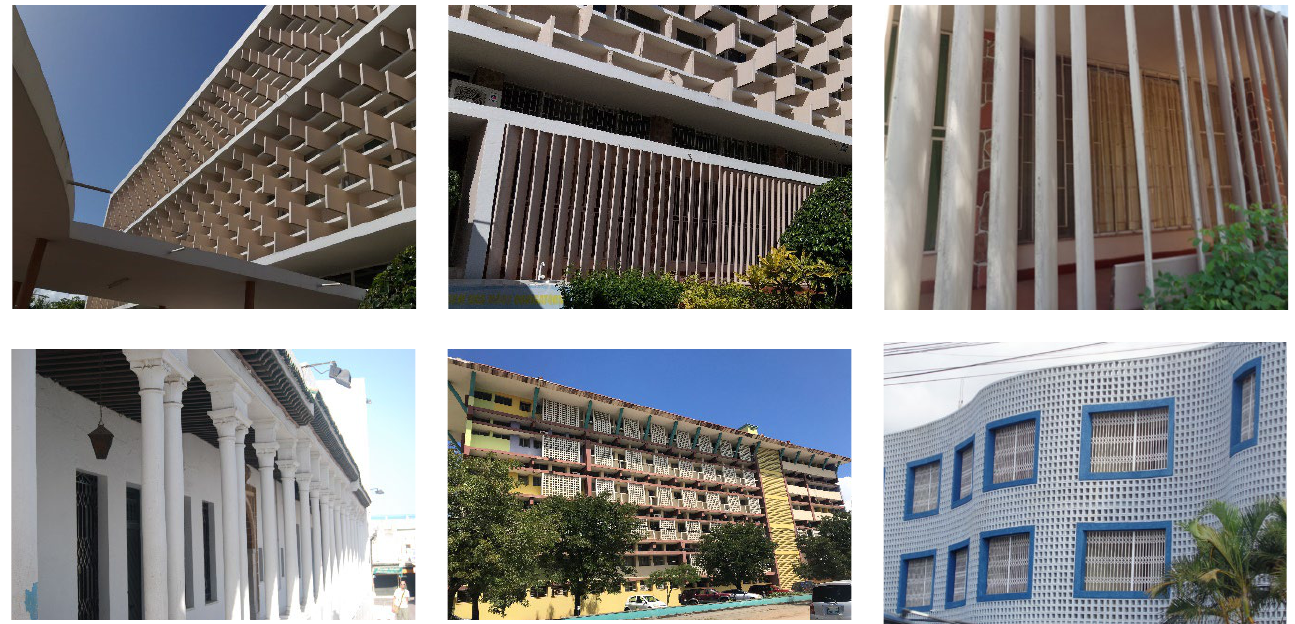
Figure 7. Examples of exterior elements that promote shading are integrated into the building architecture in Beira in Mozambique, including fixed (vertical and horizontal) canopies, movable vertical canopies, projecting balconies, fixed overhang grids, or the existence of an exterior façade with cast elements for shading.